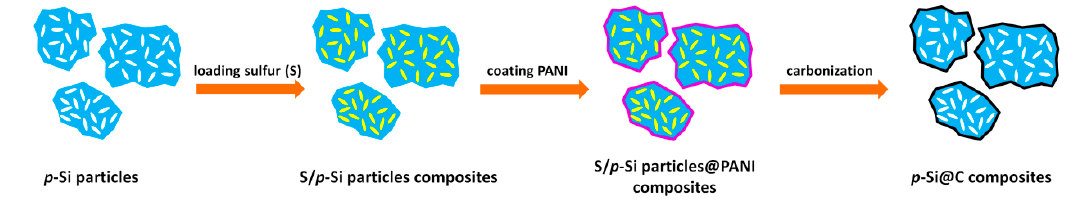
Figure 1. Schematic illustration of preparation of p -Si@C composites.